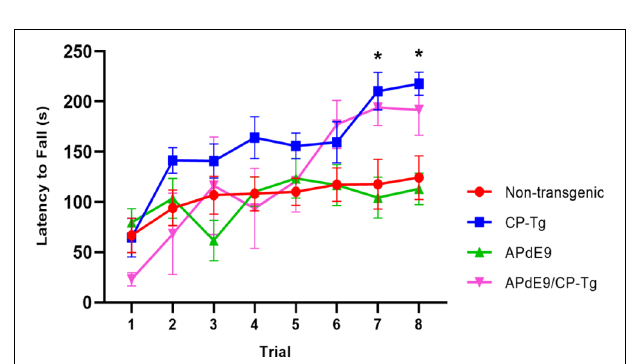
FIGURE 3 | Prostacyclin overexpression enhances motor learning and coordination. In 14–17-month-old mice, both CP-Tg and APdE9/CP-Tg mice showed improved coordination on the rotarod, compared with NTg and APdE9 mice on trials 7 and 8. Bars are means ± SEM, n = 7–8 mice per group. * p < 0.05 compared to NTg and APdE9